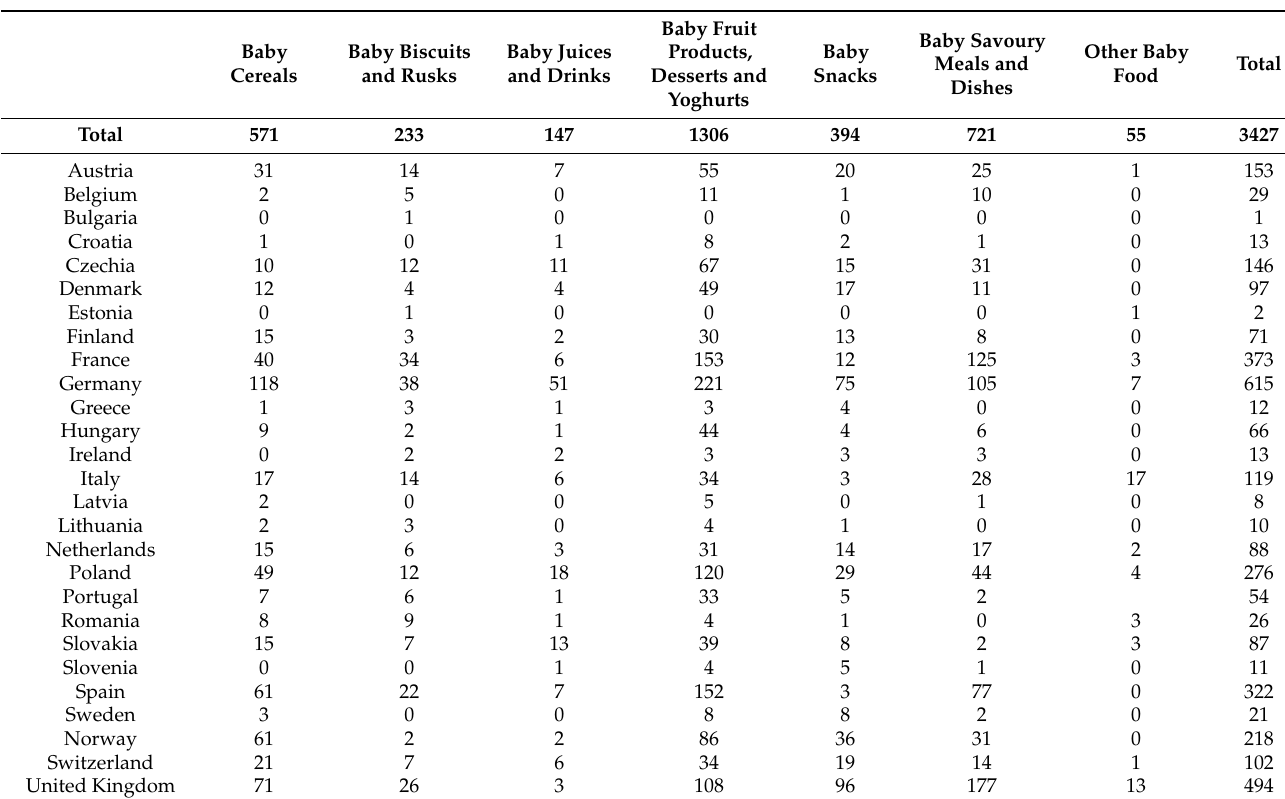
Table A2. Baby food products retrieved from the Mintel GNPD database for the period of March 2017–March 2021 by food category and country.